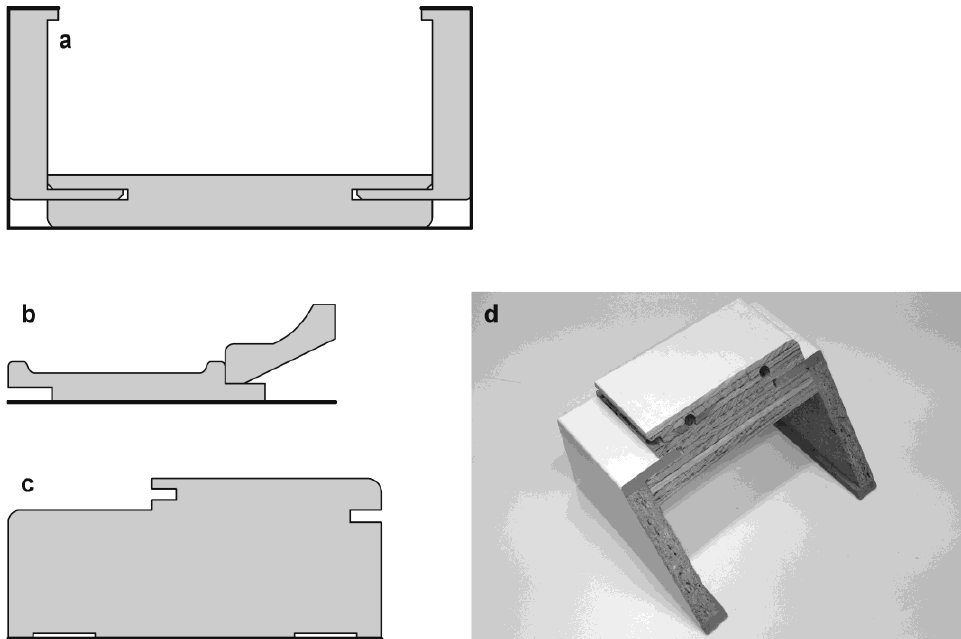
Figure 5. Schemes of cross-section door frame’s components: ( a ) PS-type door frame, ( b ) component, ( a , c ) component E160 type, ( d ) oblique cut of the door frame.